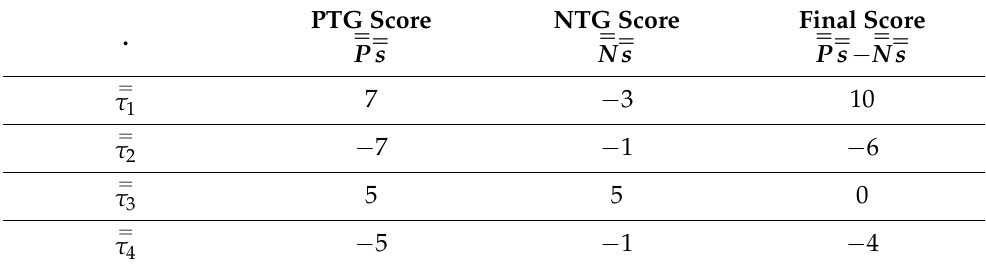
Table 18. Final score table of scenario